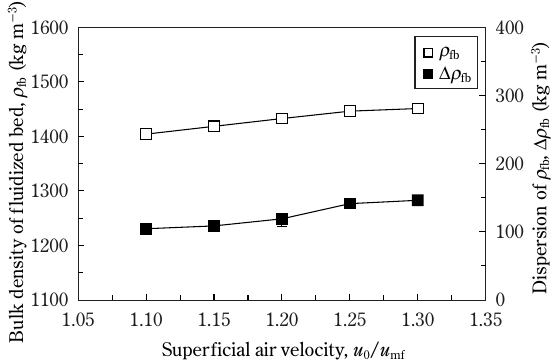
Fig. 9 Dependence of fluidized bed bulk density and its dispersion on superficial air velocity. Powder is glass